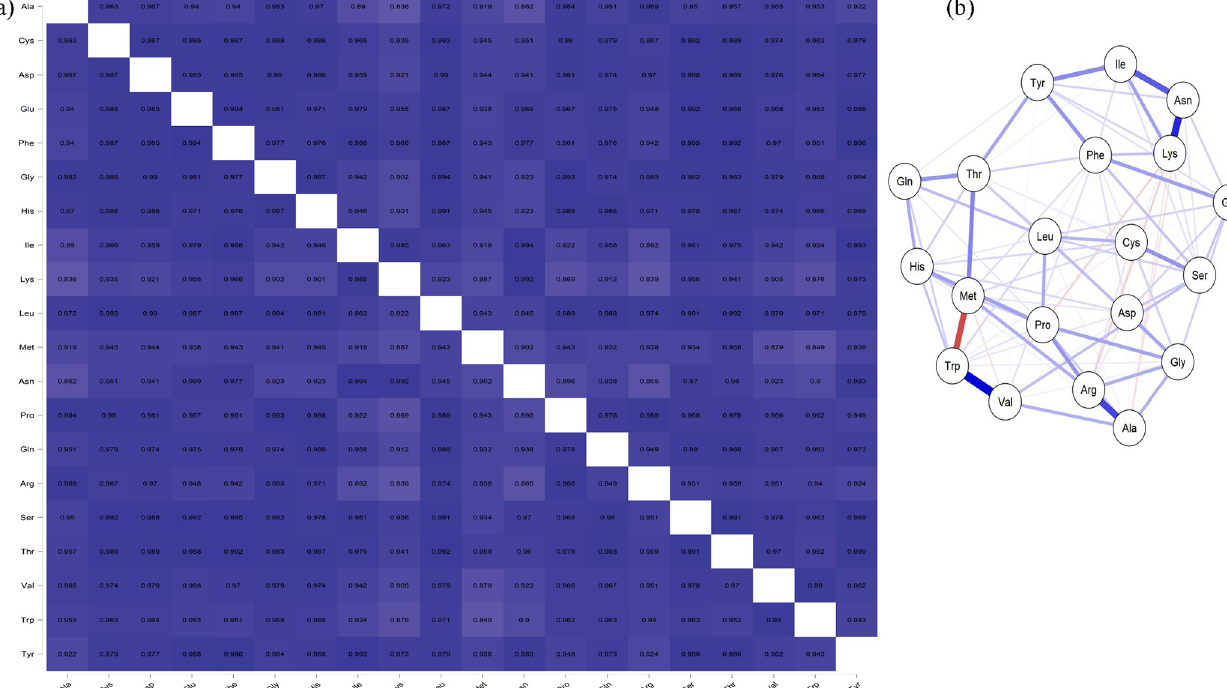
Fig 6. (a) Correlation plot of amino acid compositions and (b) network plot of amino acid composition of cyanobacterial protein. Strong and thick blue line indicates a positive correlation. The photographs was generated using mathportal server https://www.mathportal.org/calculators/statistics-calculator/